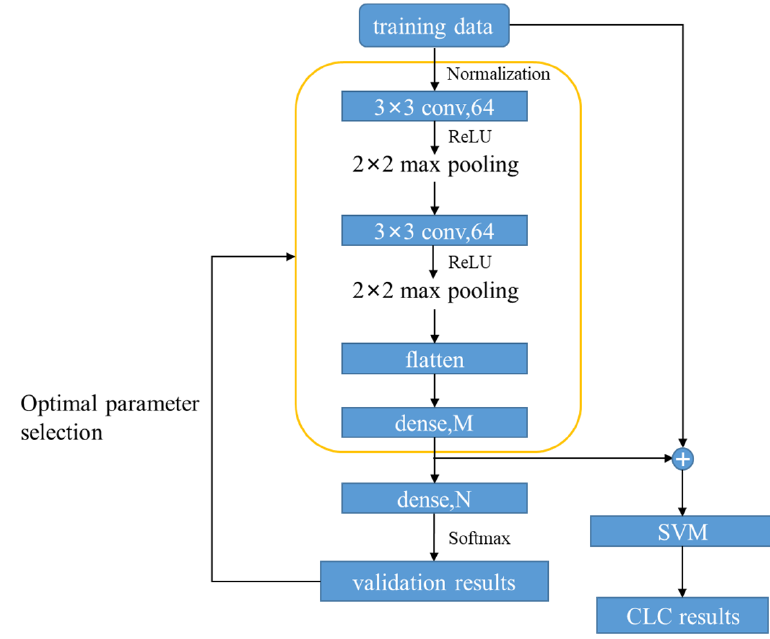
Figure 9. The structure of